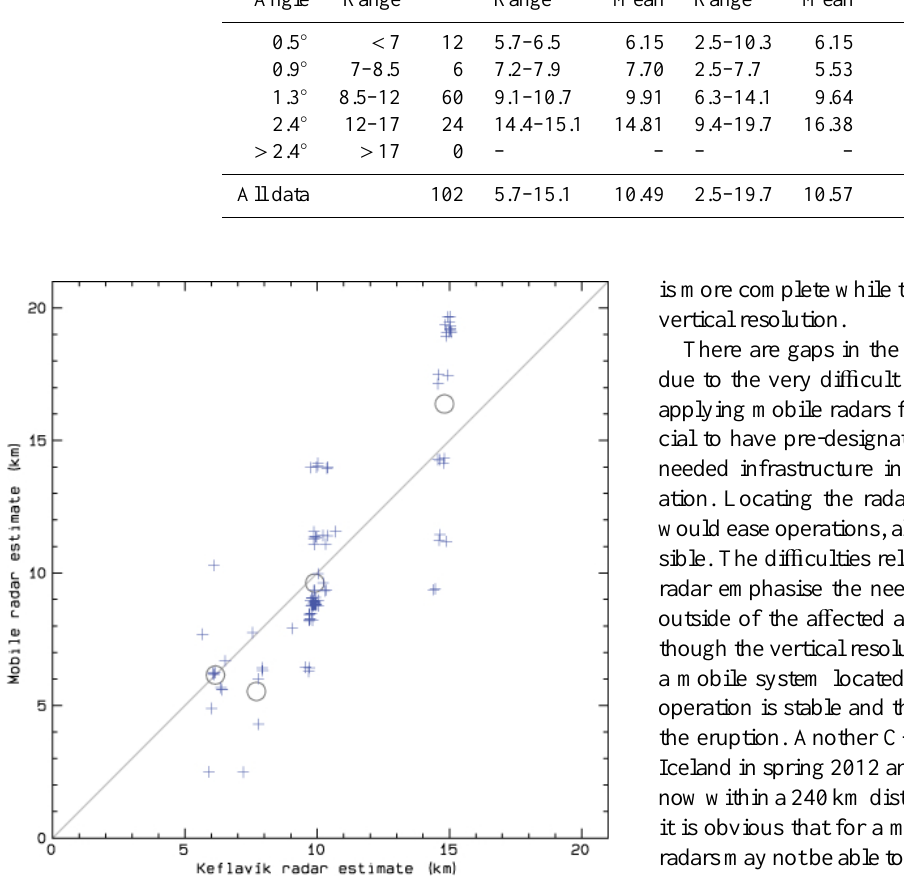
Table 3. Comparison of synchronous estimates of the plume-top altitude by the two radars. Range and mean values are in kma.s.l. Keflavík clusters N Keflavík radar Mobile radar